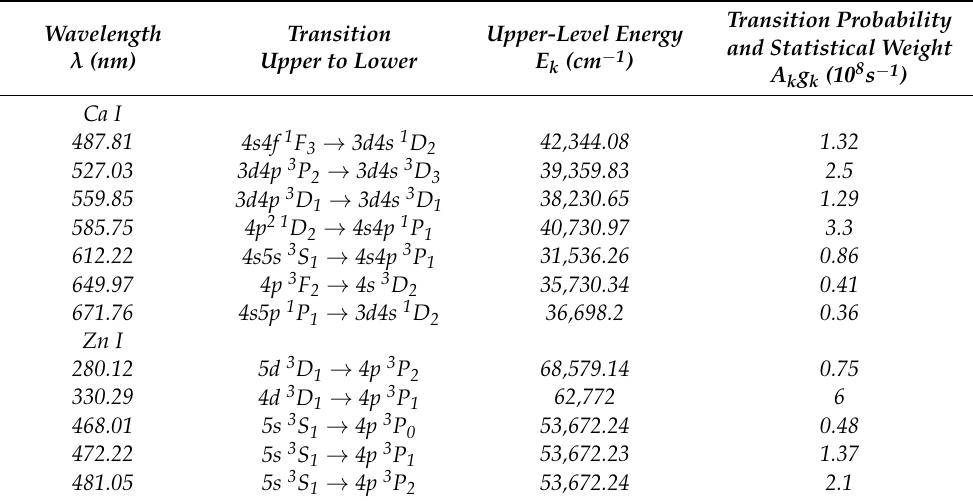
Table 2. Atomic parameters of neutral calcium (Ca I) spectral lines utilized to structure the Boltzmann